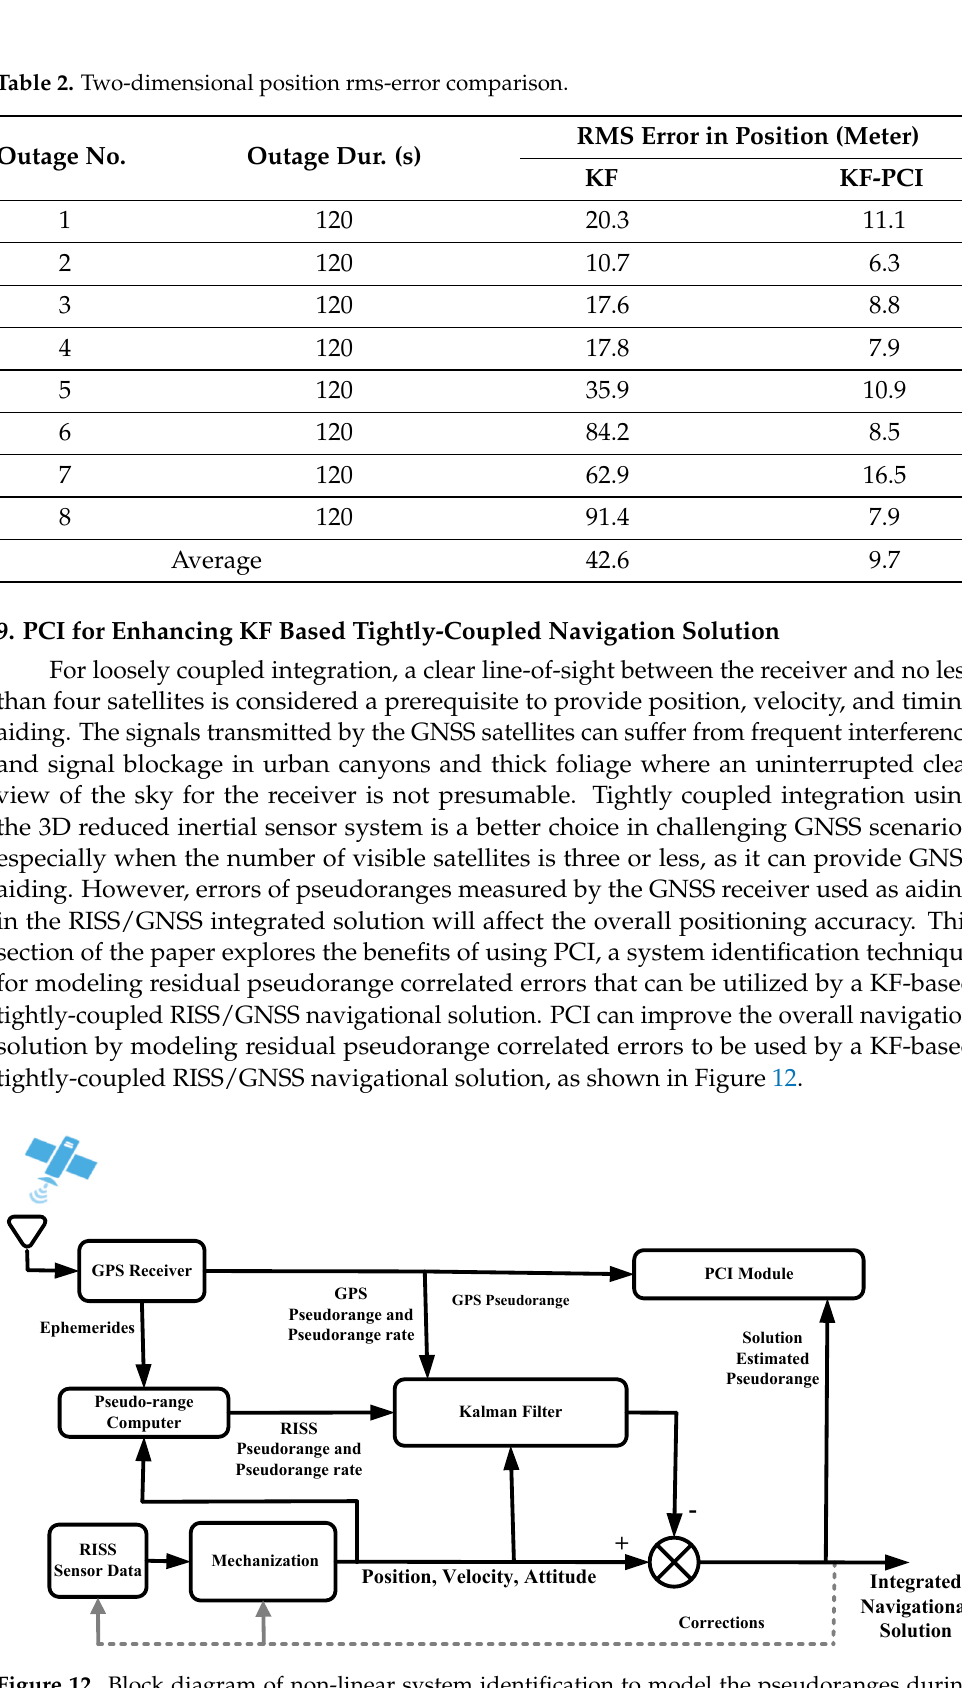
Figure 12. Block diagram of non-linear system identification to model the pseudoranges during GNSS availability using tightly coupled